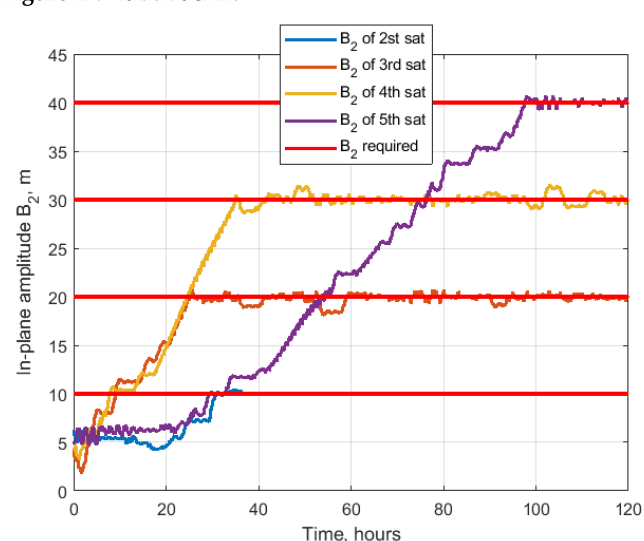
Figure 27. Relative shift.